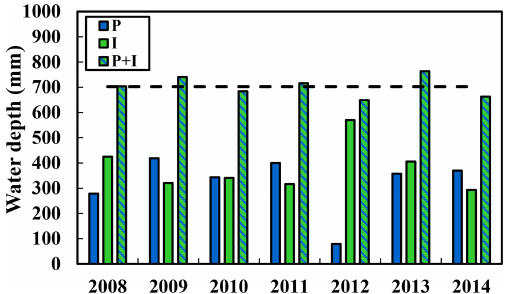
Figure 5. Observed growing season totals for precipitation ( P ), ir- rigation ( I ), and P + I . The dashed line represents the historical average for P + I .